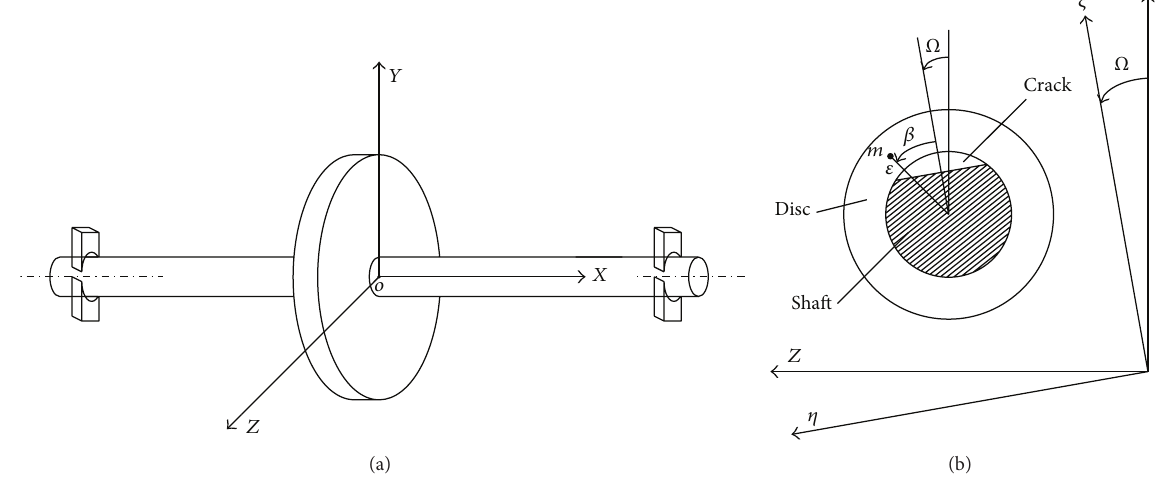
Figure 2: Stationary and rotational coordinates of a crack in a Jeffcott